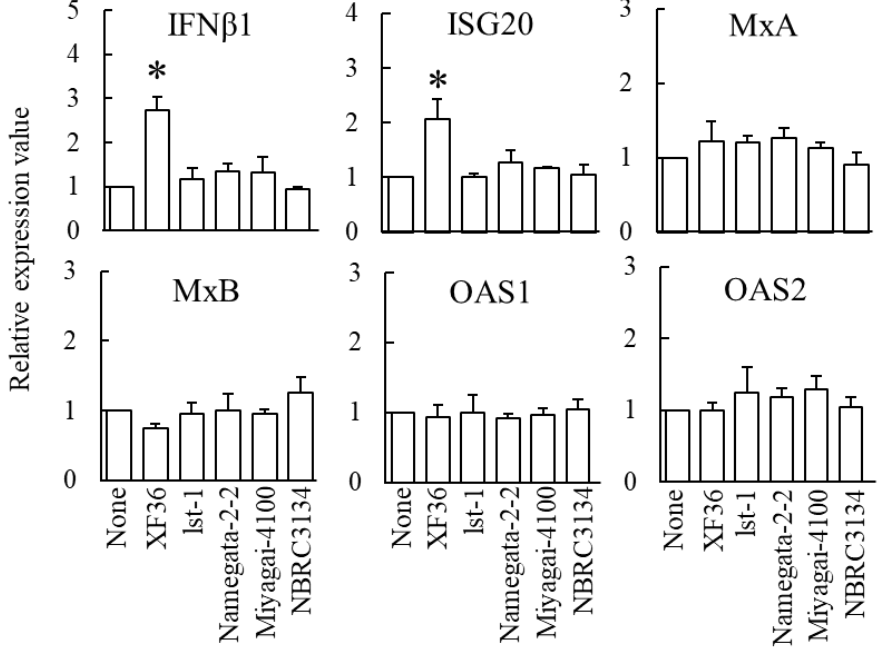
Figure 5. Effects of B. subtilis natto strains on the expression of antivirus factor genes in the cell culture model mimicking single-stranded RNA viral infection. M1-phenotype macrophages were cultivated with 1 µ g/mL resiquimod (RSQ) only (none), 1 µ g/mL RSQ, and 10 µ g/mL B. subtilis natto strain (XF36, lst-1, Namegata-2-2, or Miyagi-4100), or 1 µ g/mL RSQ, and 10 µ g/mL B. subtilis NBRC3134 for 3 h. Quantitative real-time reverse transcription polymerase chain reaction assessed the relative expression values. The data are presented as the mean and SD ( n = 3). The comparison among multiple groups was evaluated using Dunnett’s posttest following ANOVA. * p < 0.05 (vs. none).